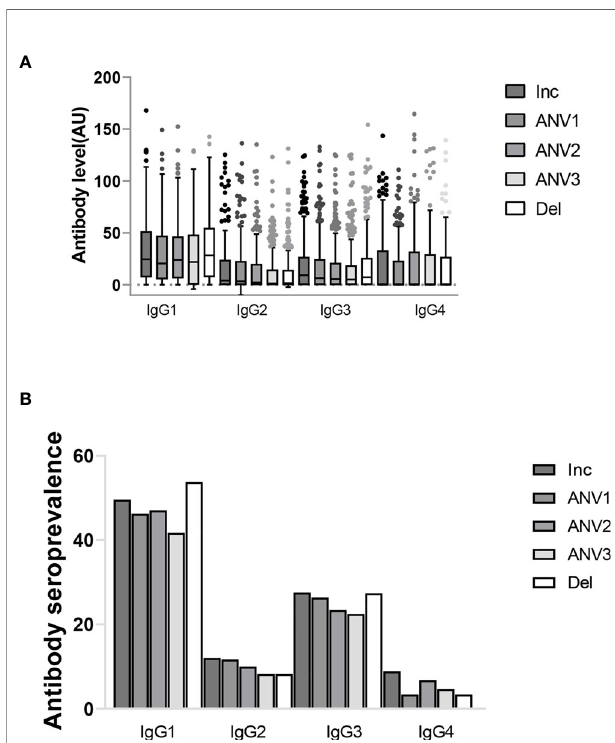
FIGURE 1 | IgG subclass pro fi le to ID1-ID2a recombinant protein from pregnant women followed during the course of pregnancy (inclusion, antenatal visits (ANV) and delivery). (A) The distribution of IgG subclasses. Shown are IgG subclasses antibody levels (median and IQR) in arbitrary units. (B) IgG subclass seroprevalence. The pro fi le of IgG subclasses clearly shows a cytophilic IgG ’ s (IgG1 and IgG3) are the predominant IgGs while low prevalence of non-cytophilic IgG ’ s (IgG2 and IgG4) were also observed.